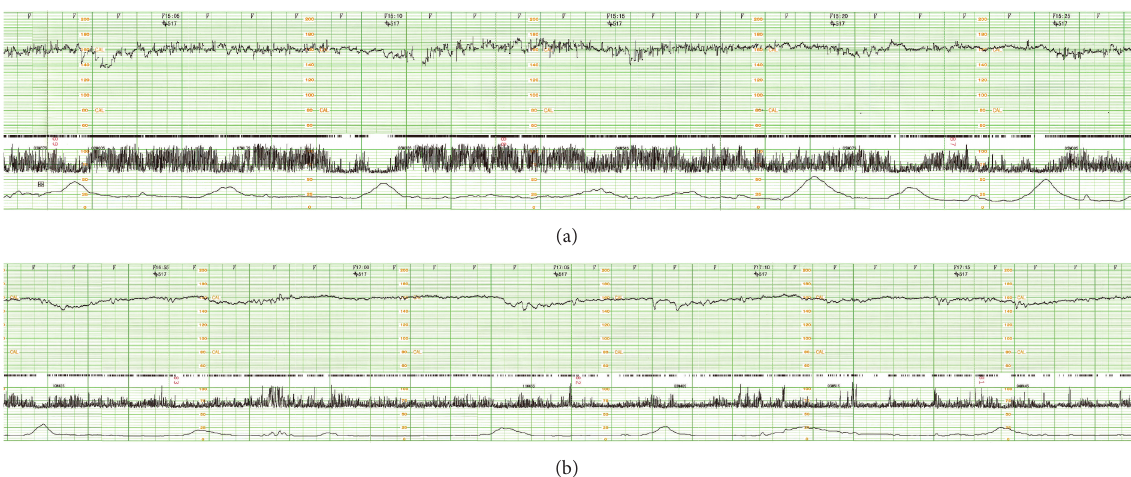
Figure 2: Cardiotocogram indicates a nonreassuring fetal status. (a) Cardiotocogram on admission. The fetal heart rate is 160 beats/min, with minimal variability and recurrent mild to severe late decelerations without any acceleration. (b) Cardiotocogram after endoscopic hemostasis. The findings are similar to those observed in (a). However, late decelerations are also noted during every mild uterine contraction, which is not observed on